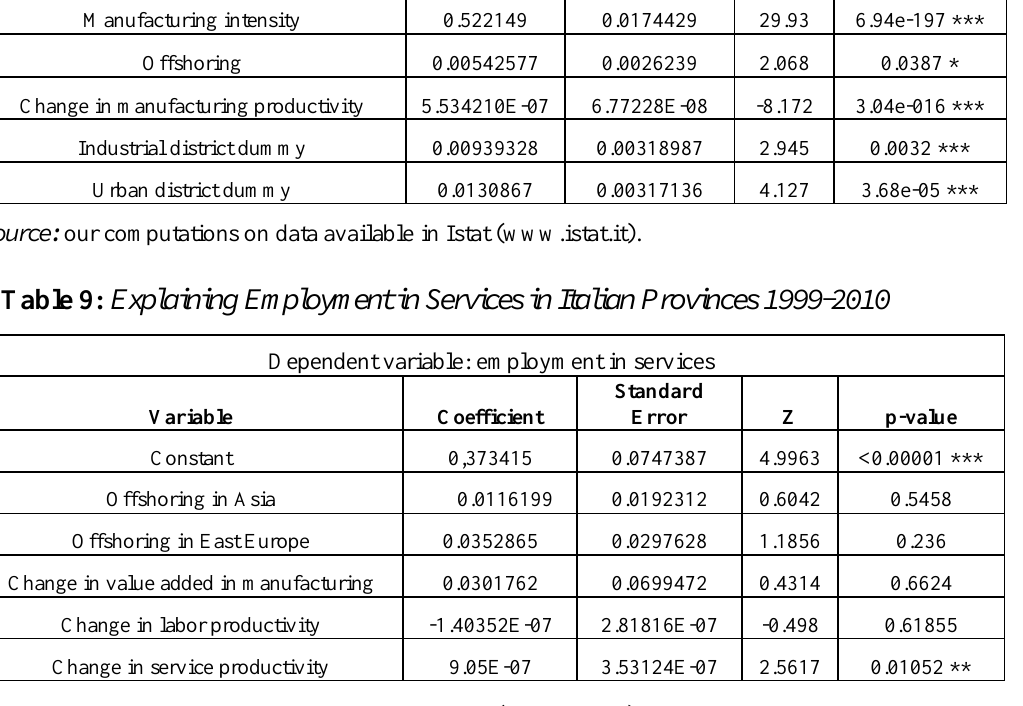
Table 8: Explaining Employment in Manufacturing in Italian Provinces 1999-2010 Dependent variable: employment in manufacturing Variable Coefficient Standard Error